Question: Identify the chart type used in this figure.
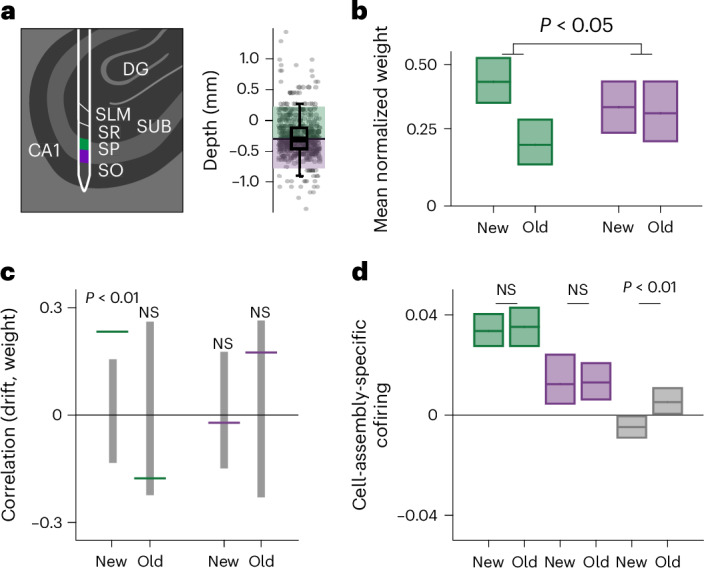
Answer: scatter